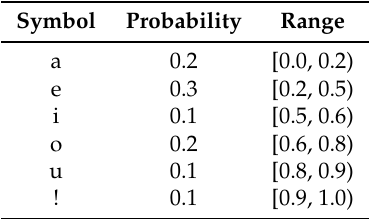
Table A1. Symbols probabilities and ranges for fixed model Arithmetic coder